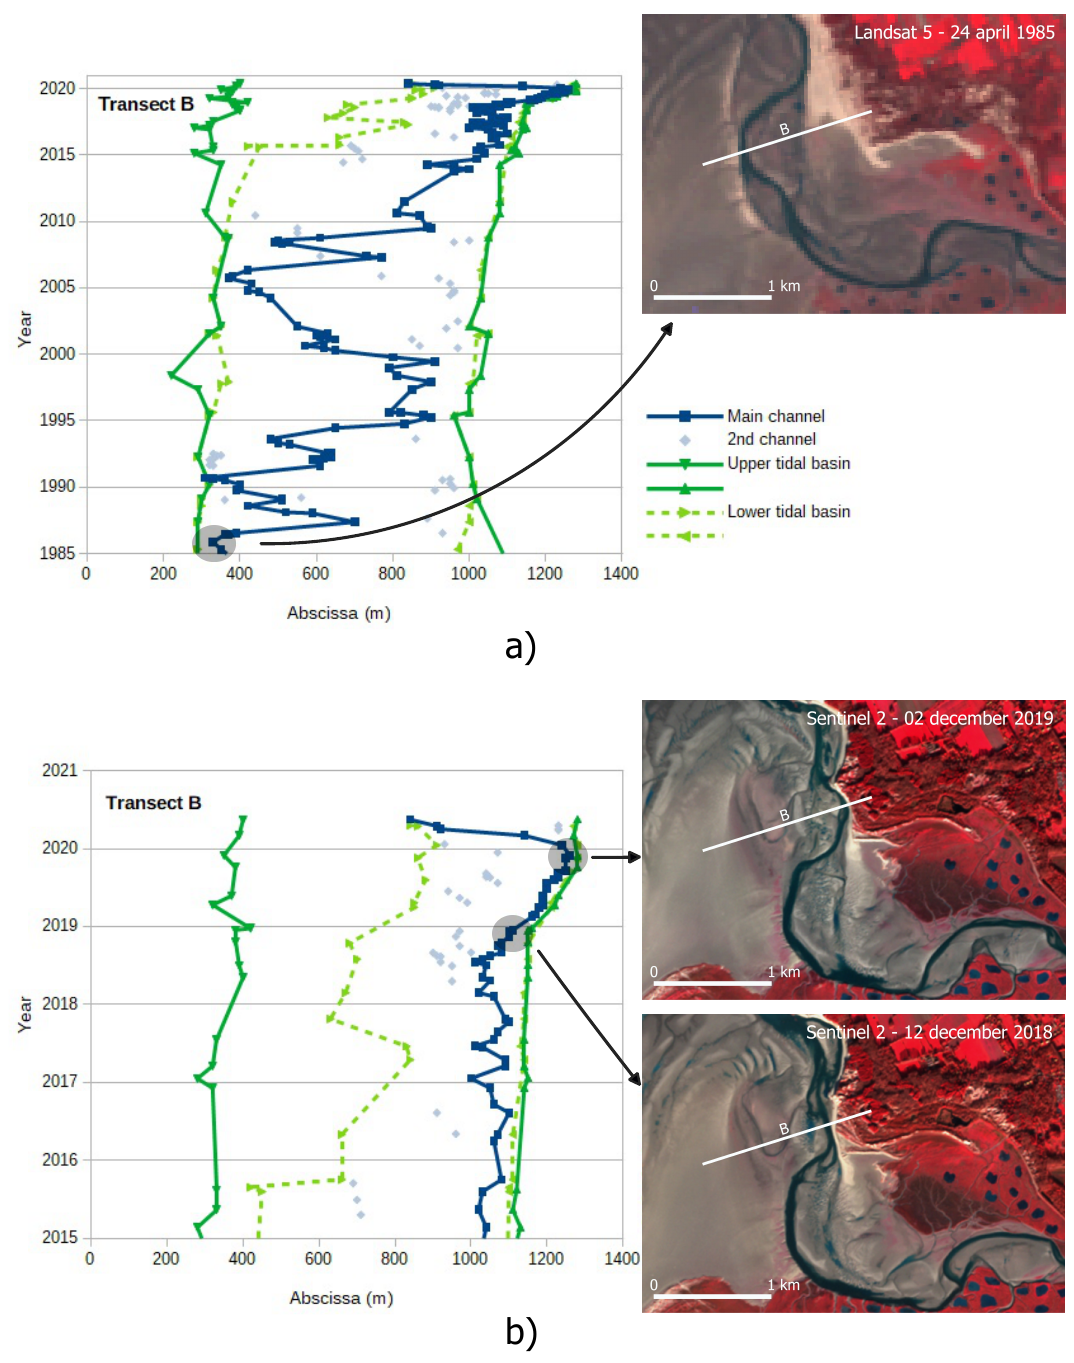
Figure 11. ( a ) Chronicles of the Authie meanders from 1985 to 2020 along transect B. ( b ) Zoom of the chronicles over the period 2015 to